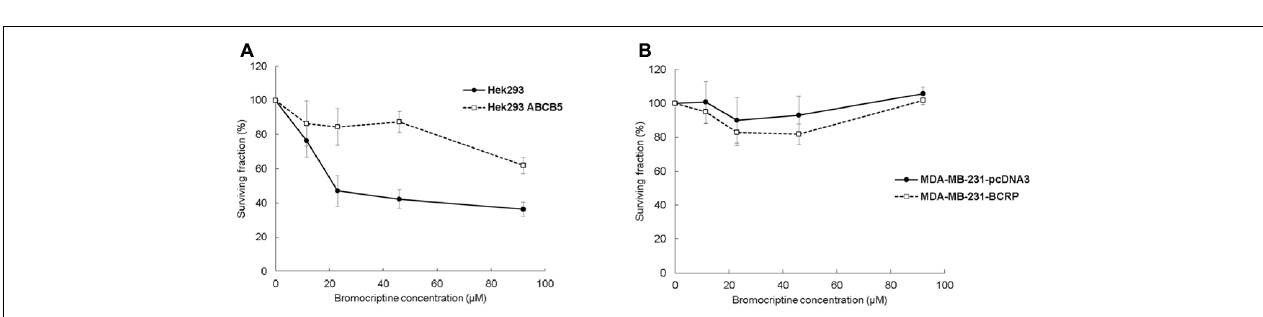
FIGURE 2 | Clonogenic assays for (A) Hek293, Hek293 ABCB5 and for (B) MDA-MB-231-pcDNA and MDA-MB-231-BCRP cells.